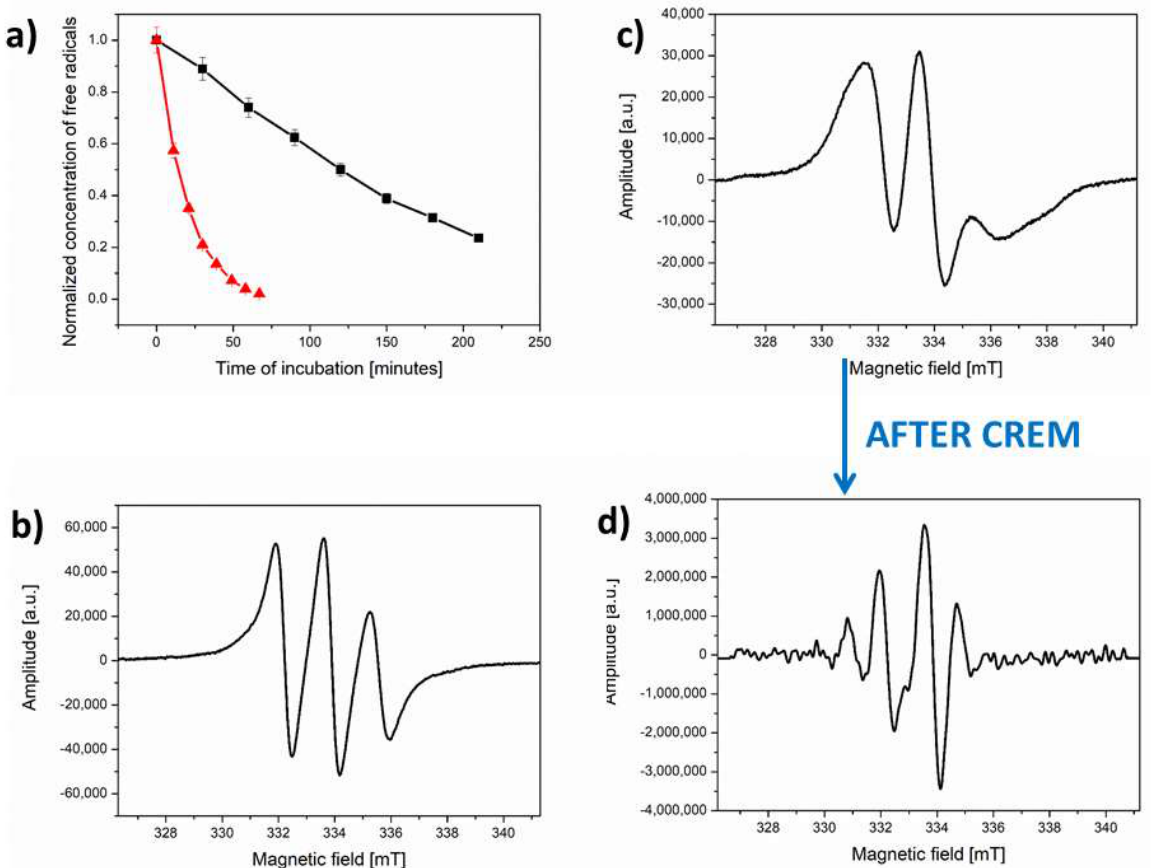
Figure 6. Decrease in the spin probe concentration during incubation with yeast cells determined by ESR signal intensity ( a ) of TEMPO ( ▲ ) and TEMPOL ( ■ ) and the exemplary ESR spectra at the beginning of incubation of TEMPO ( b ) and TEMPOL before ( c ) and after CREM process ( d ).